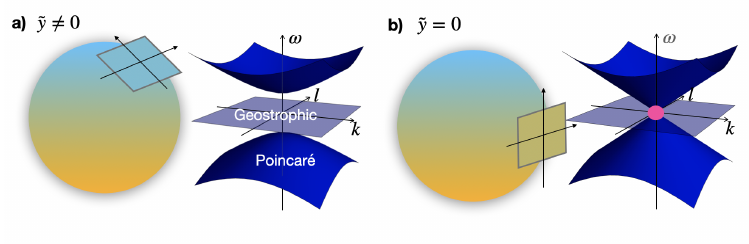
Figure 3: Dispersion relation of shallow water waves on a plane tangent to the planet, assuming constant Coriolis parameter f = ˜ y (Kelvin wave problem). Geostrophic modes correspond to the Rossby modes of the Matsuno wave problem. The pink dot corresponds to the band degeneracy point that plays a central role in the topology of shallow water waves [ 5 ]